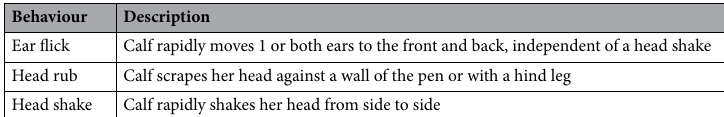
Table 1. Description of pain behaviours observed following hot-iron disbudding. Based on Duffield et al.